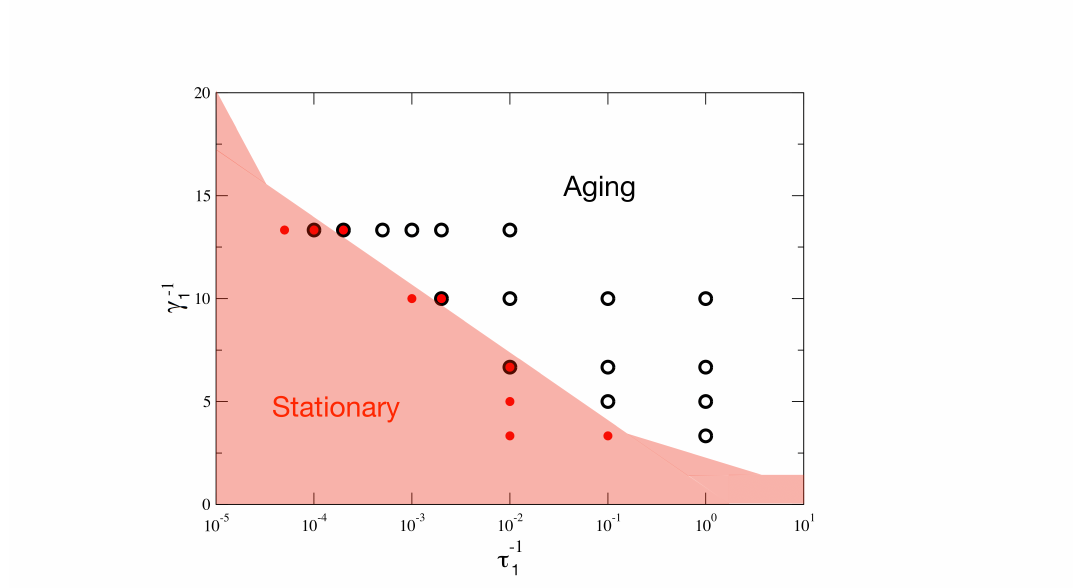
Figure 4: The phase-diagram of the model with a multithermalized external field. The system is made of N = 2 12 spins with random bimodal coupling constants (cid:112) = ± 1 / J N . The spin temperature is T = 0.7 and the field temperature is T (cid:48) = ∞ . ij The points in the figure represent all the parameter choices investigated. The black circles correspond to an aging system, the red dots to a stationary one. Black cir- cles with a red dot inside correspond to ambiguous cases where the three criteria discussed in the text give weak or opposite indications. The shaded red region is a pictorial representation of the stationary